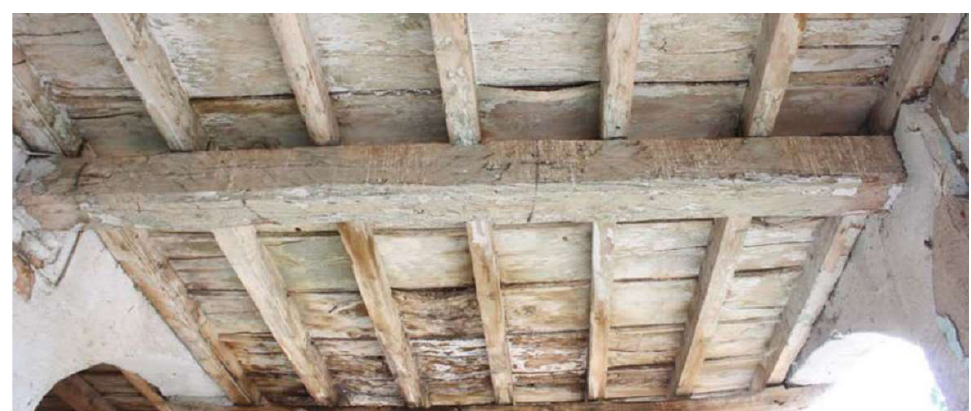
Figure 6. Gallery; detail of an open-node truss.